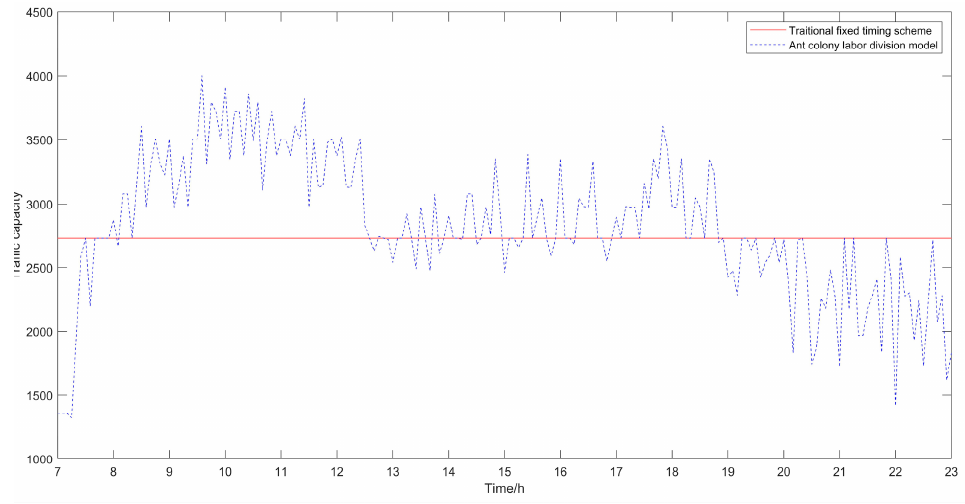
Figure 7. Comparison diagram of traffic capacity at intersections.